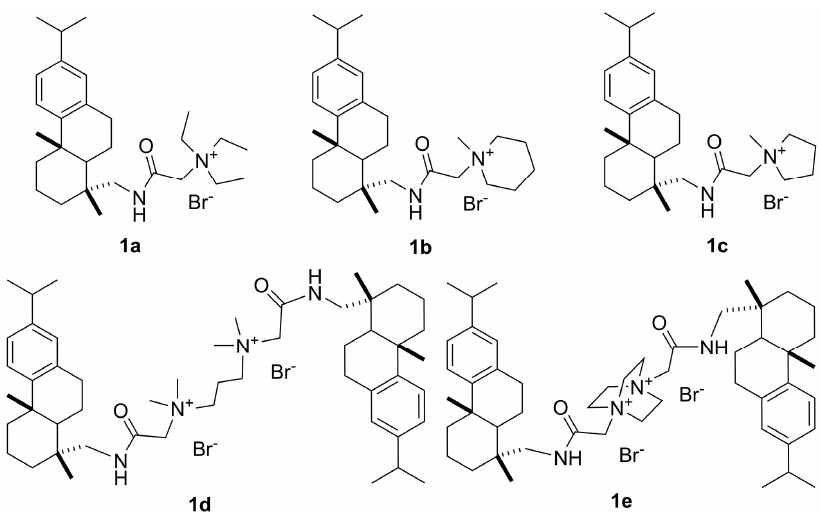
Figure 2. Structure of quaternary ammonium salt derived from commercially available dehydroabietylamine.